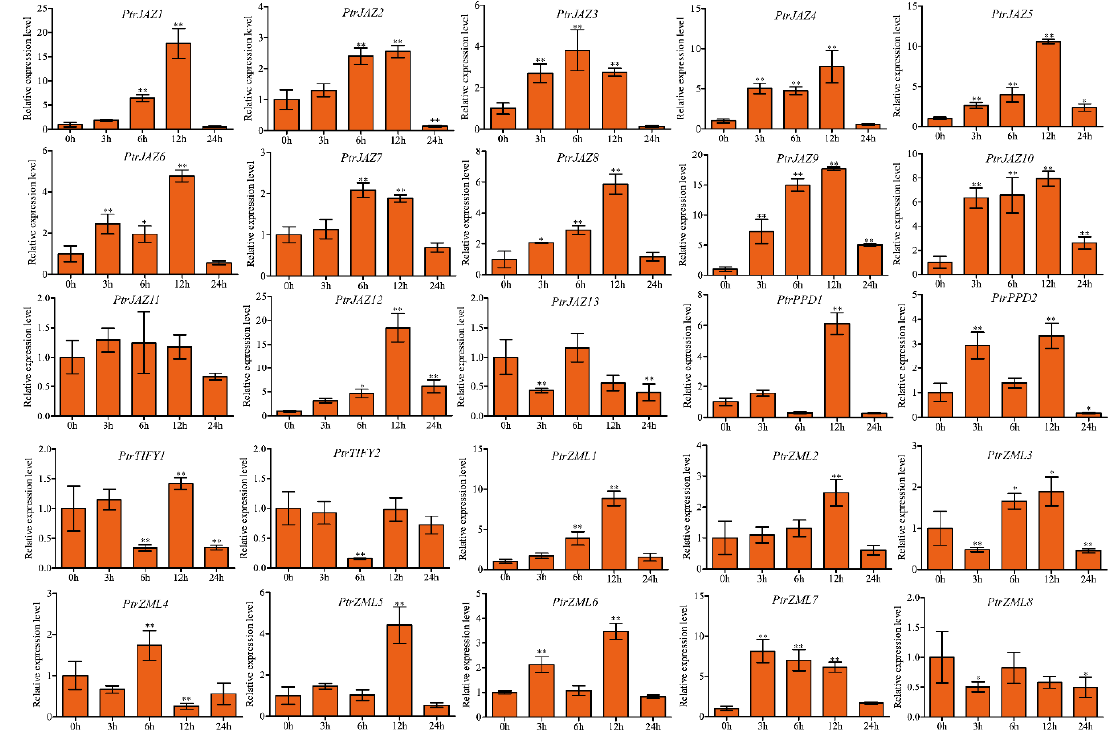
Figure 7. Expression analysis of PtrTIFY genes in root under 200 μ M ABA treatment by qRT–PCR. Error bars represent the standard deviations from three biological replicates. Asterisks indicate stress treatment groups that showed a significant difference in transcript abundance compared with the control group (* p < 0.05, ** p < 0.01).